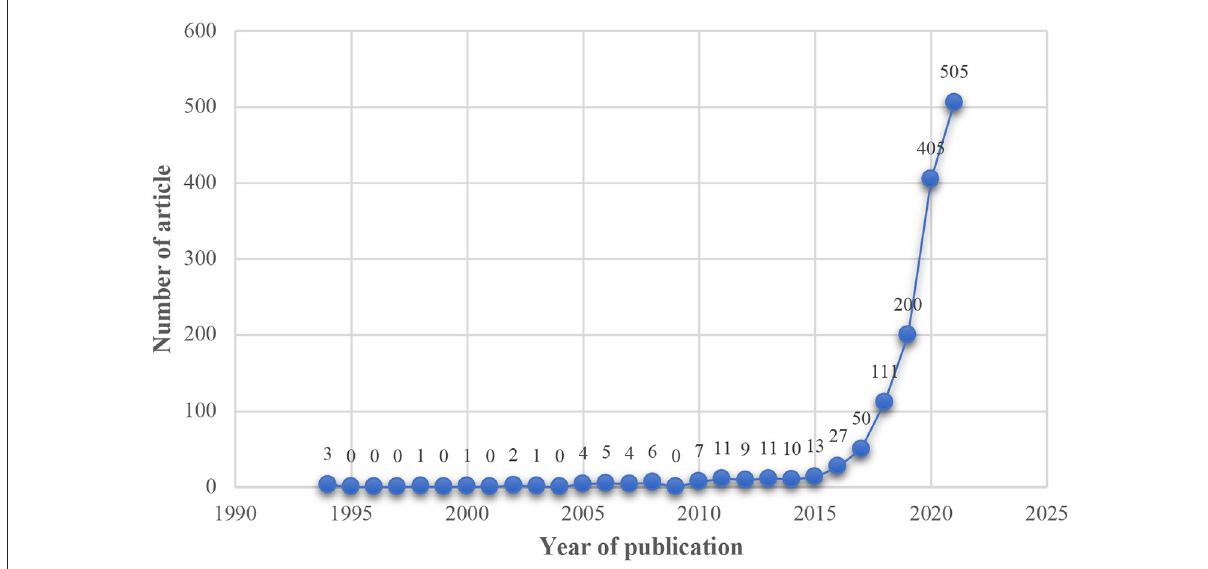
FIGURE1 The distribution of the articles by year ( N = 1,386). The search ended October 12, 2021.